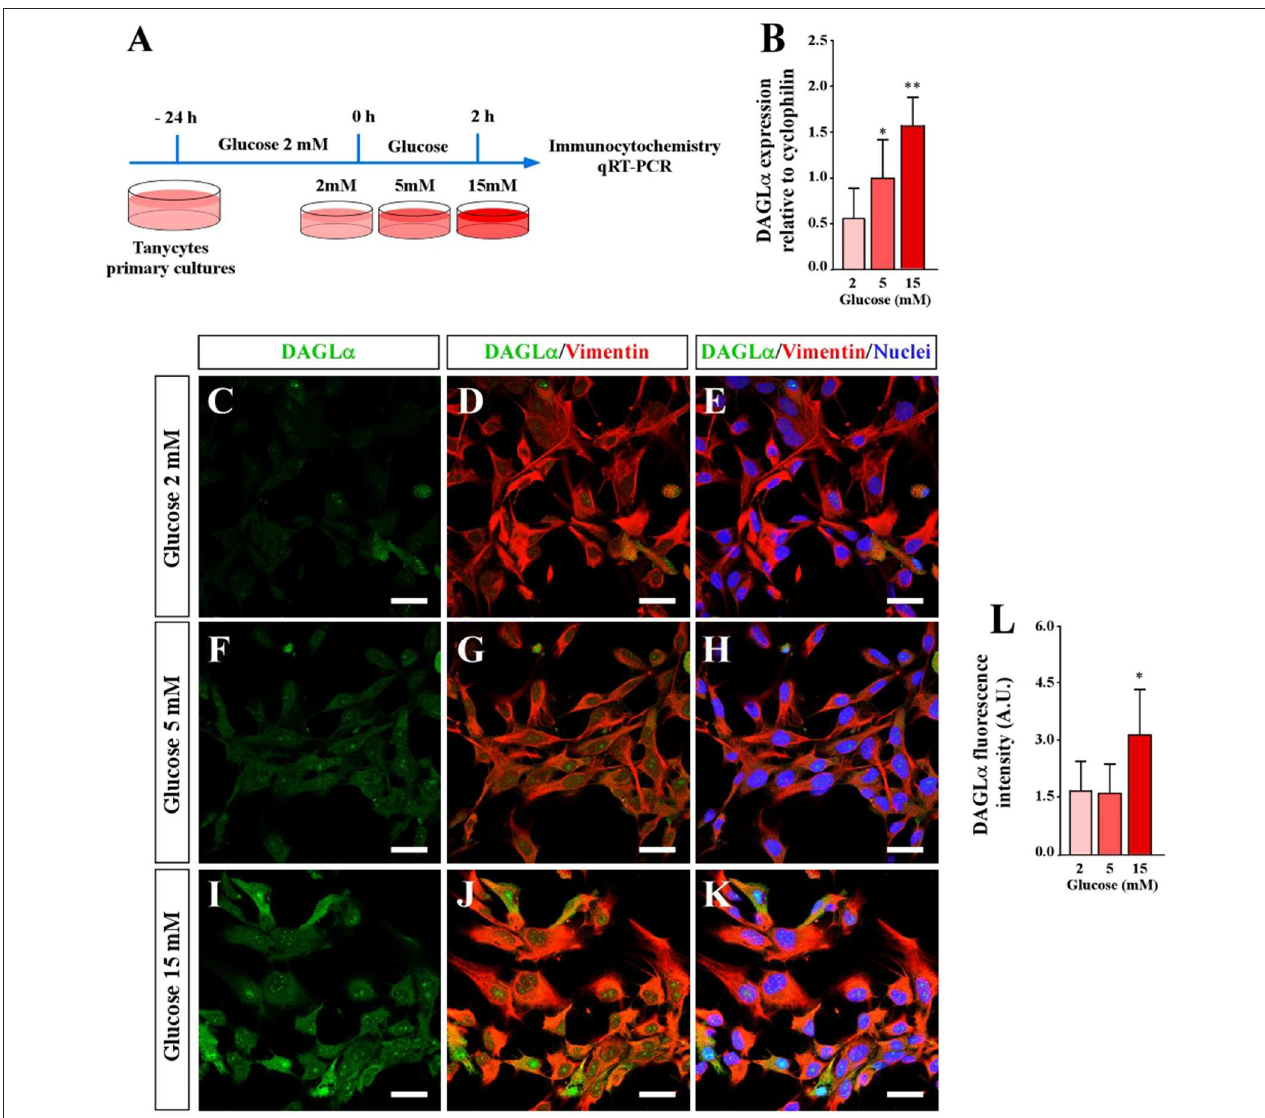
FIGURE 1 | Effect of extracellular glucose on DAGL α expression using primary cultures of tanycytes. (A) Scheme of the experimental protocol. (B) qRT-PCR analysis DAGL α mRNA expression 2h post incubation with 2, 5, and 10mM glucose. (C–K) Confocal microscopy of tanycytes incubated in several glucose conditions and stained with anti-DAGL α (green), anti-vimentin (red) and TOPRO-3 as a nuclear marker. (C–E) 2mM glucose. (F–H) 5mM glucose. (I–K) 15mM glucose. Scale bar: 20 µ m. (L) Quantification of the fluorescent signal associated with DAGL α . Bars represent average ± S.D. * p < 0.05, ** p <